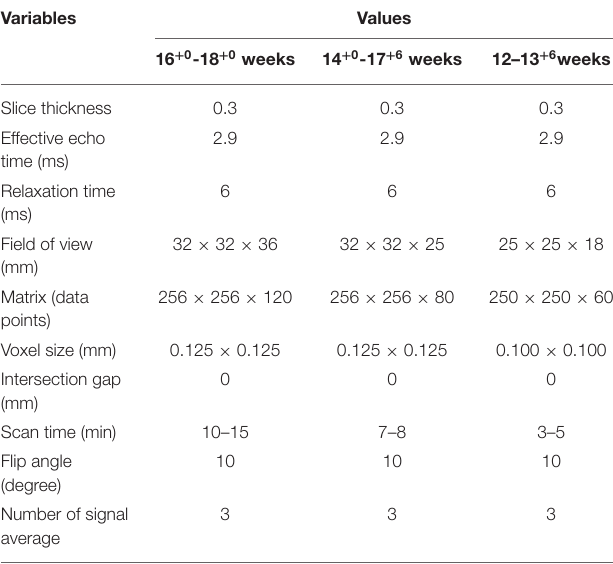
TABLE 1 | Typical MRI variables for three-dimensional T1-weighted